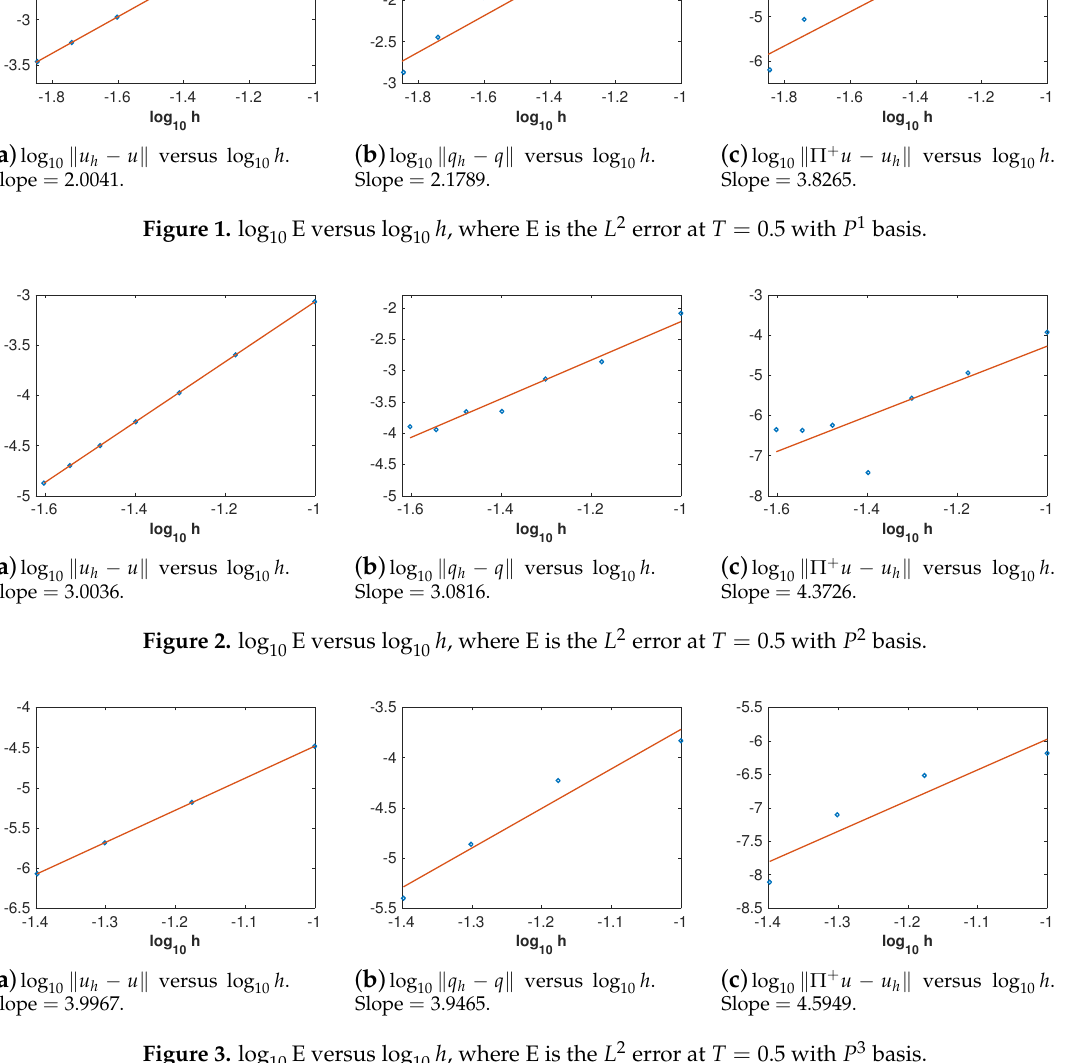
h , where E is the L 2 error at T = 0.5 with P 3 Figure 3. log E versus log 10 10